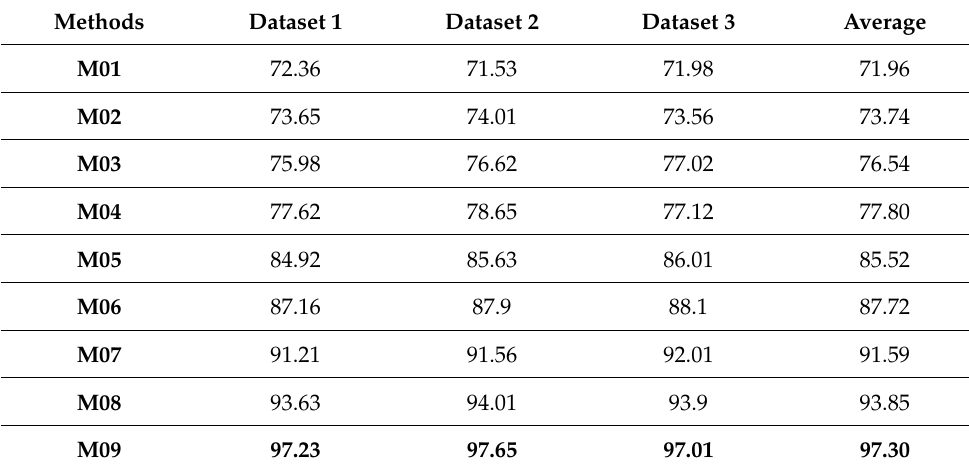
Table 14. Accuracy results for sentiment classification using the MFMLSC.